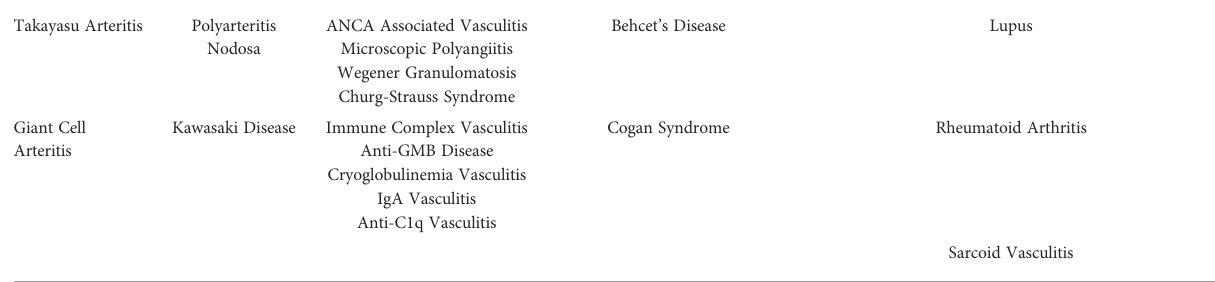
TABLE 1 Vasculitides Organized based on Vessel Size as well as syndromic presentations. Information drawn from 2012 International Chapel Hill Consensus Conference 13,14. . Large Vessel